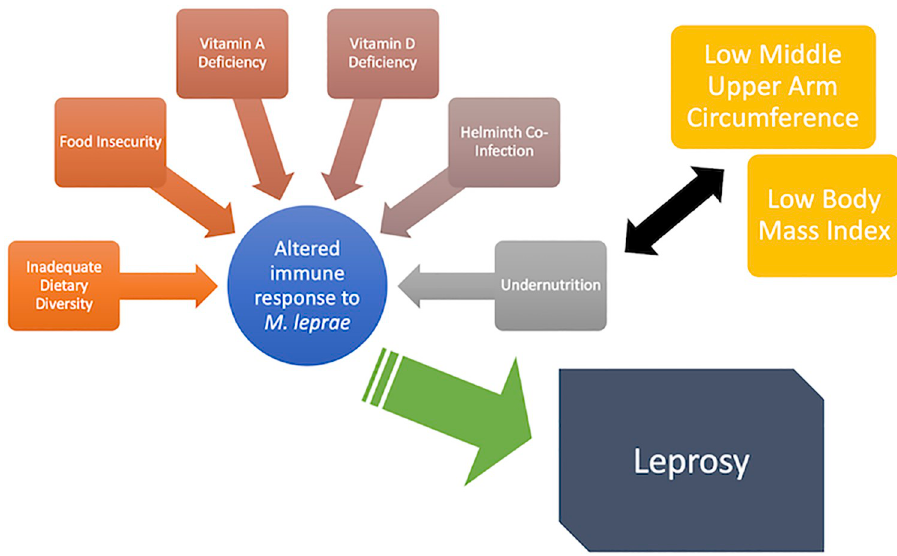
Fig 3. Diagram showing possible relationships between food insecurity, dietary diversity, nutritional deficiencies, undernutrition, M . leprae infection, and leprosy manifestation.